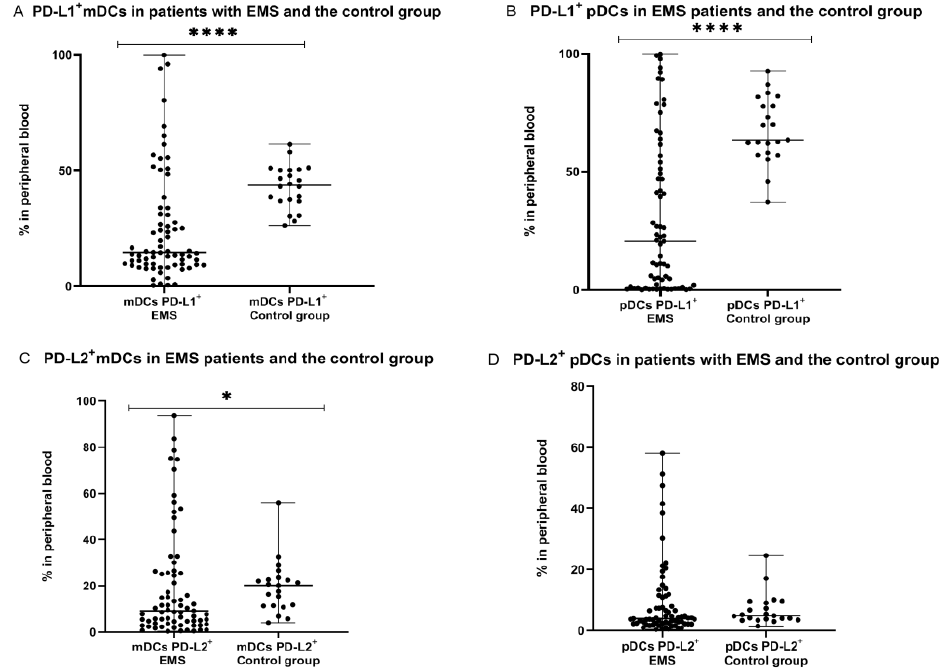
Figure 5. Percentage of mDCs and pDCs with PD-L1 and PD-L2 expression in peripheral blood in endometriosis patients and the control group ( A – D ). The median values with the following signs indicate statistically significant differences: * p < 0.05, **** p < 0.0001.